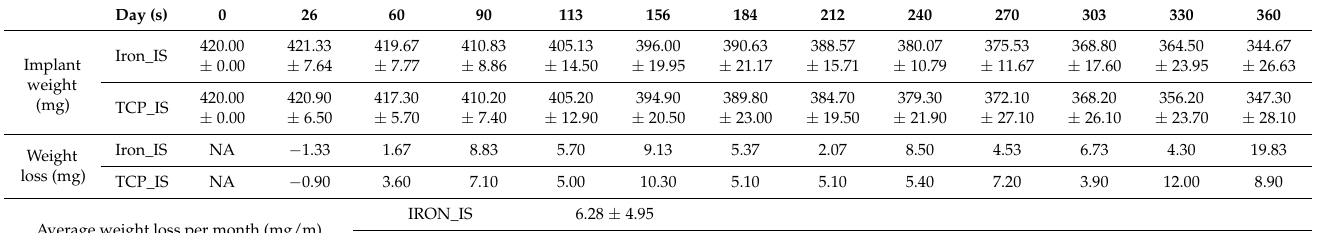
Table 1. In vitro immersion test results of iron_IS and TCP_IS implant weights.